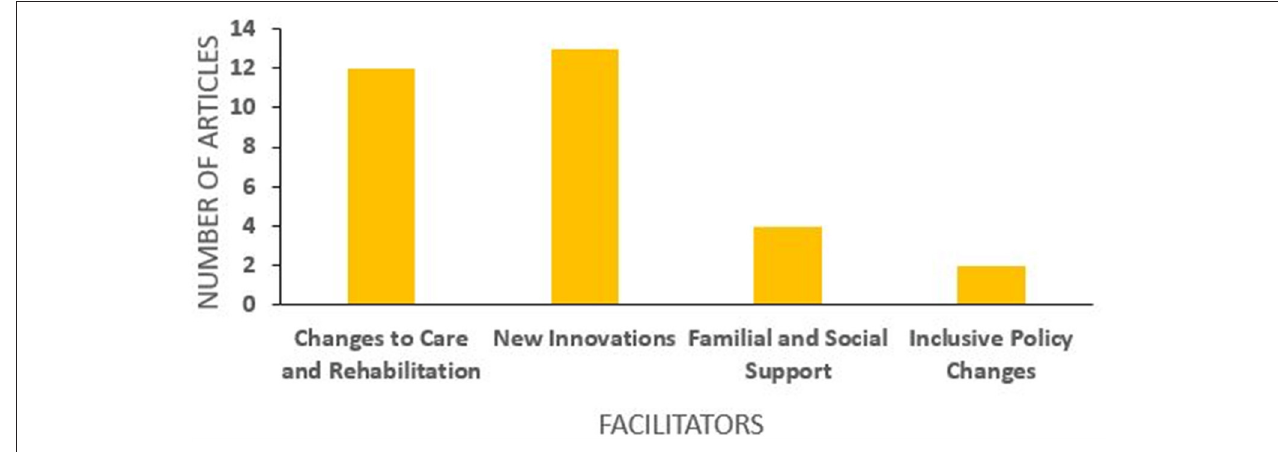
FIGURE 6 | Number of articles per